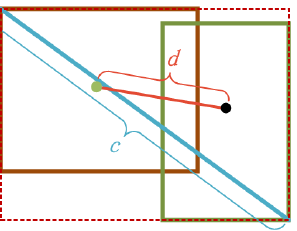
Figure 5. Illustration of the center point